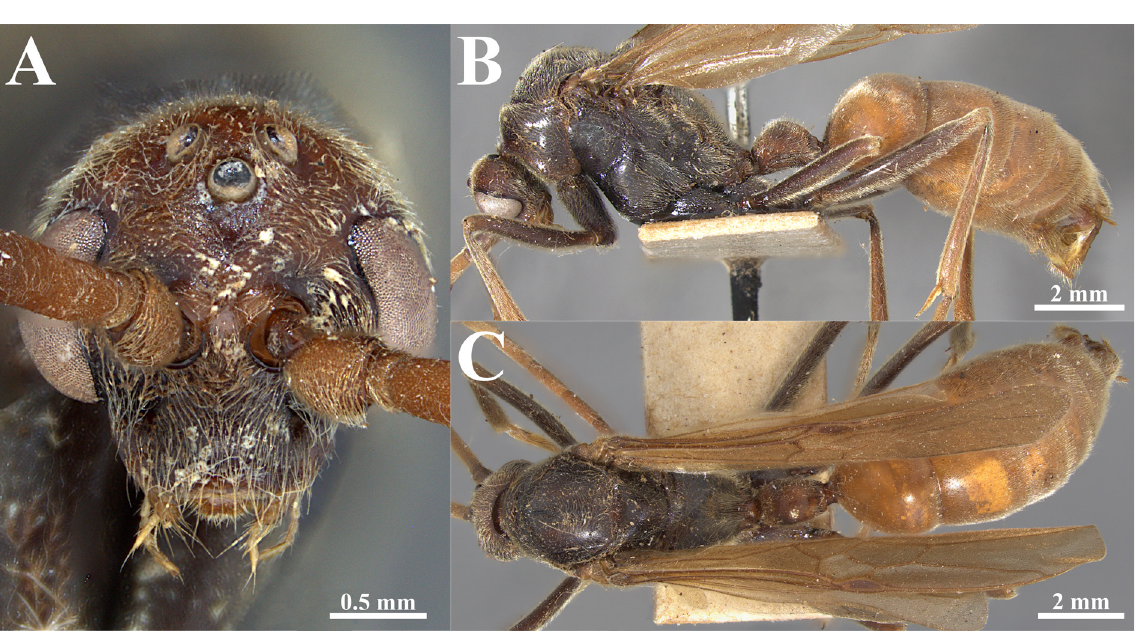
Grande do Sul, Brazil; MZSP 65800). A . Full-face view. B . Full body in lateral view. C . Full body in dorsal